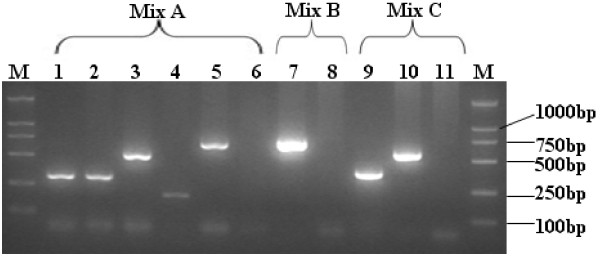
The specificity of the 3 multiplex mixes of primers (A, B and C) evaluated using plasmids and standard sera containing the HBV genome. M: molecular weight standards; Lane 6, 8 and 11: negative controls; Lane1 and 9: standard sera of subgenotype B2; Lane 2 and 10: plasmid of subgenotype B1; Lane 3: standard serum of subgenotype C1; Lane 4: plasmid of subgenotype C2; Lane 5: plasmid of genotype D; Lane 7: plasmid of genotype A.